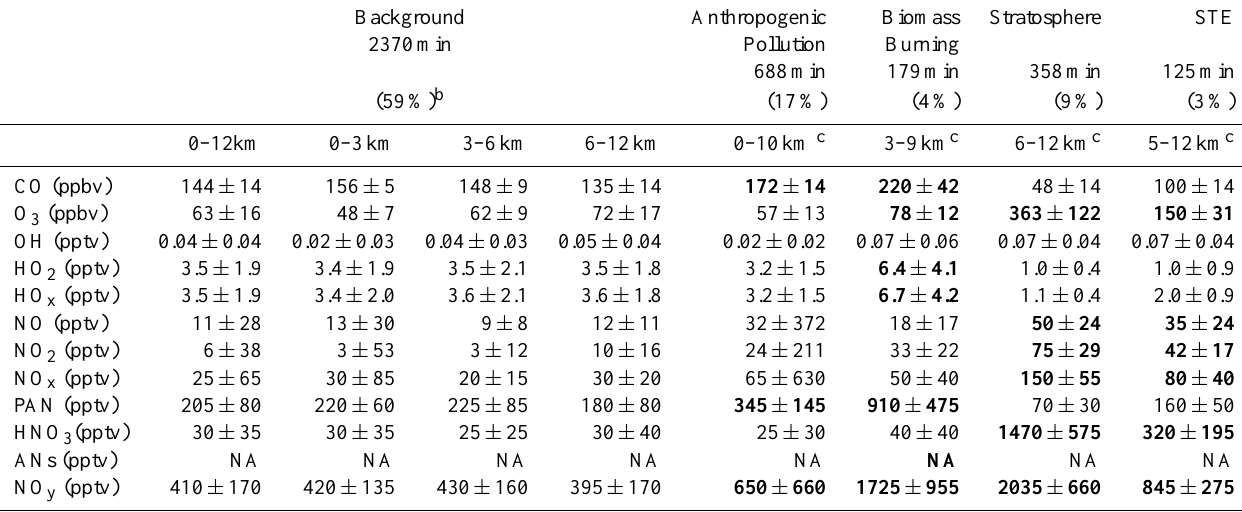
Table 3a. Mean observed chemical composition of air masses sampled during ARCTAS-A a